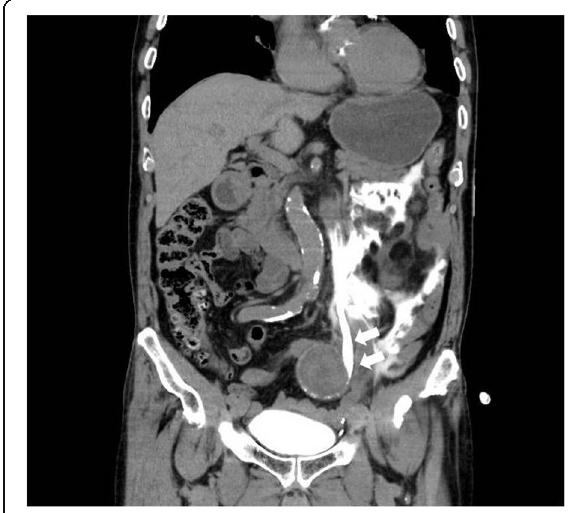
hydroureteronephrosis and leakage of iodinated urine in the left- side retroperitoneum. Arrows indicate the left ureter compressed by